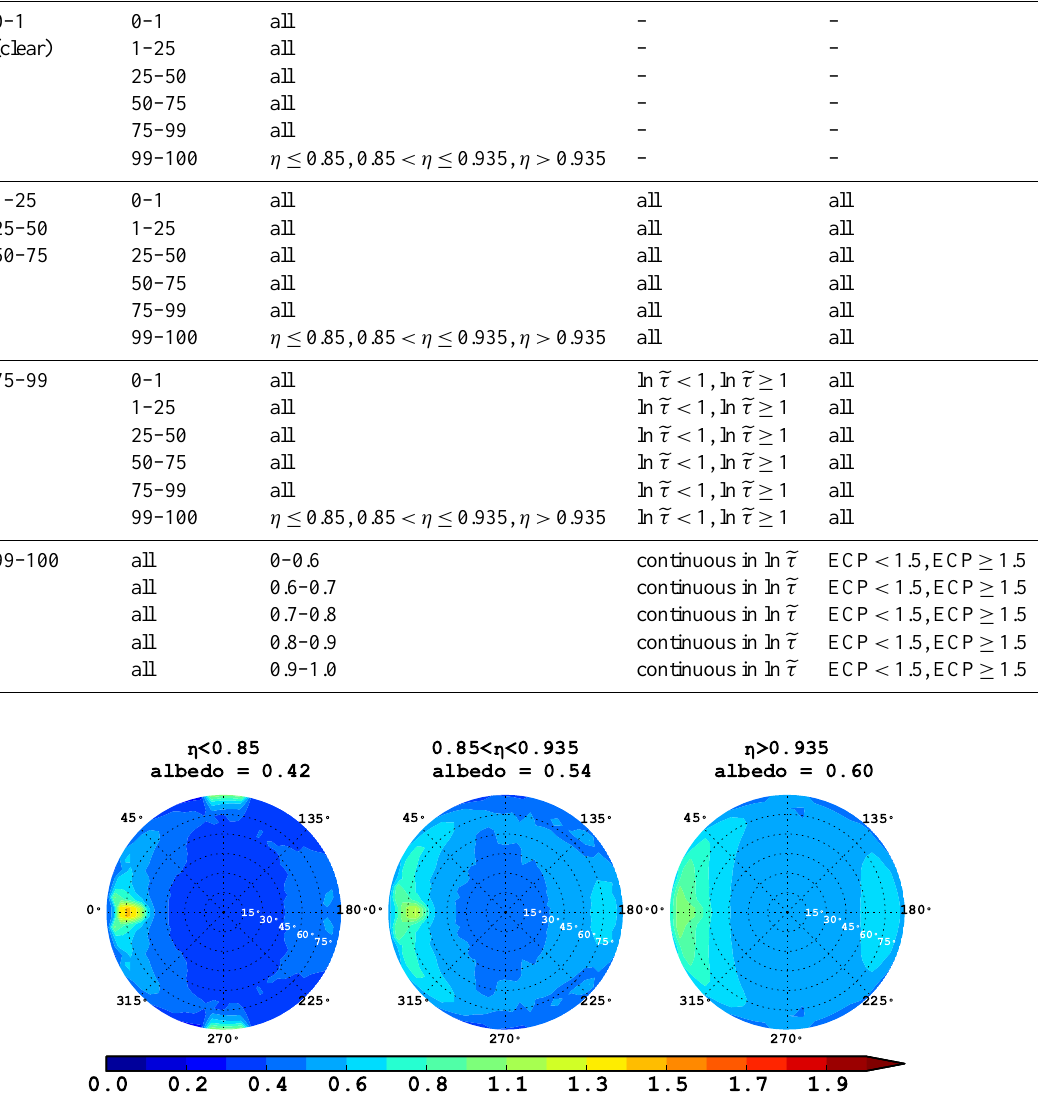
Figure 13. Clear-sky sea ice BRDFs for three η classes for θ 0 = 65–70 ◦ .